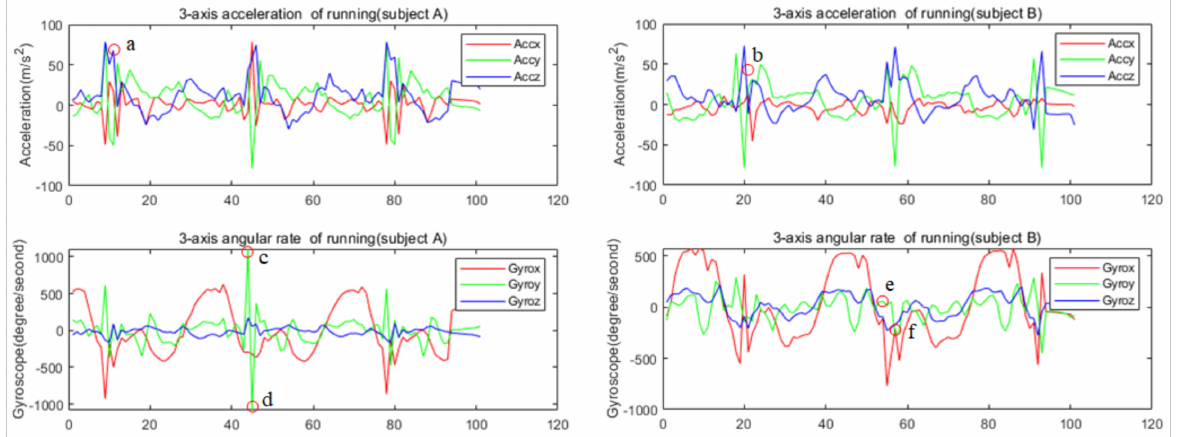
Figure 1. IMU signal of different people on running. a, b, c, d, e, f: the different moment of IMU signal when two people are